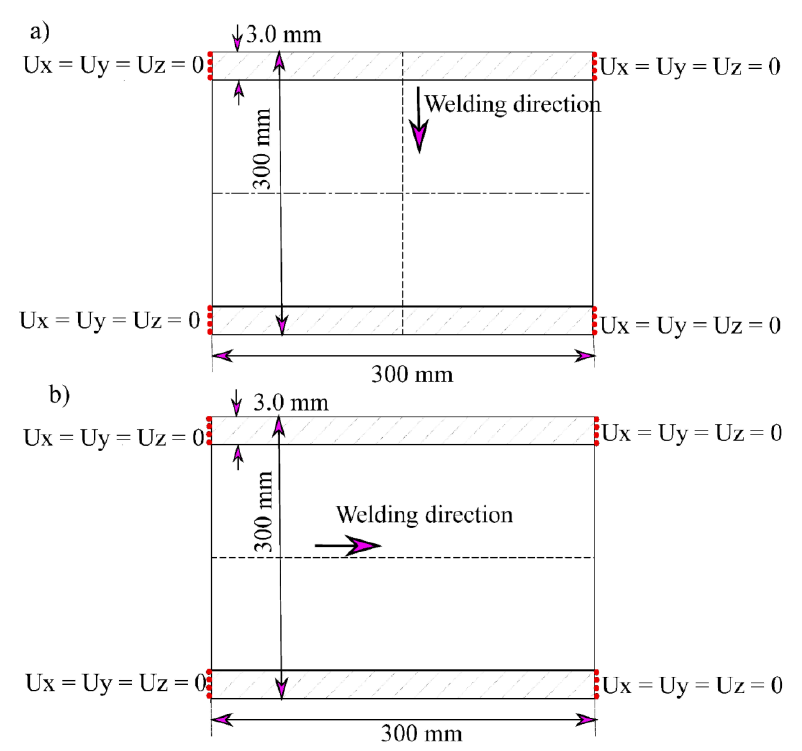
Fig. 5. Boundary conditions applied during structural analysis for a) circumferential weld joint and b) longitudinal weld